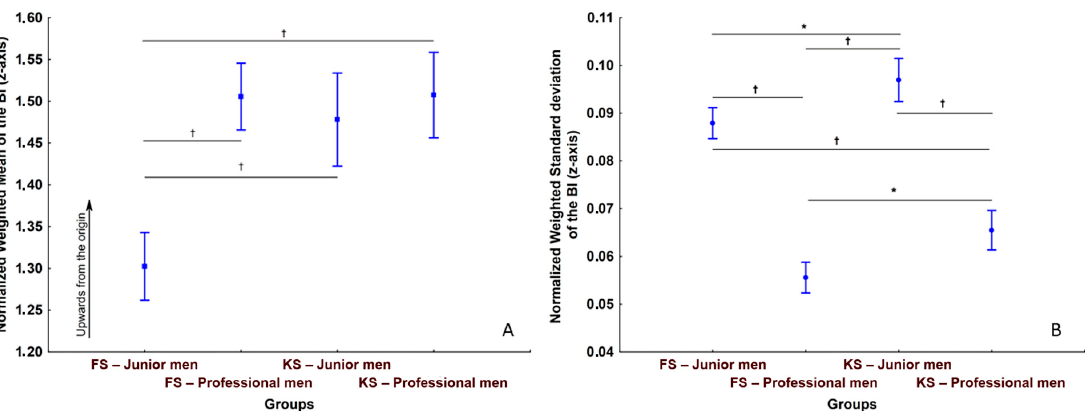
Figure 6. Differences in the ball impact location on the z -axis (professional and junior men). Note: FS—flat serve; KS—kick serve; * Significant differences between professional and junior men and the serve type, p < 0.05.; † Significant differences between professional and junior men and the serve type, p < 0.01 Vertical bars denote 95% CIs. Note: ( A ) normalized weighted mean of the ball impact, ( B ) normalized weighted standard deviation of the ball